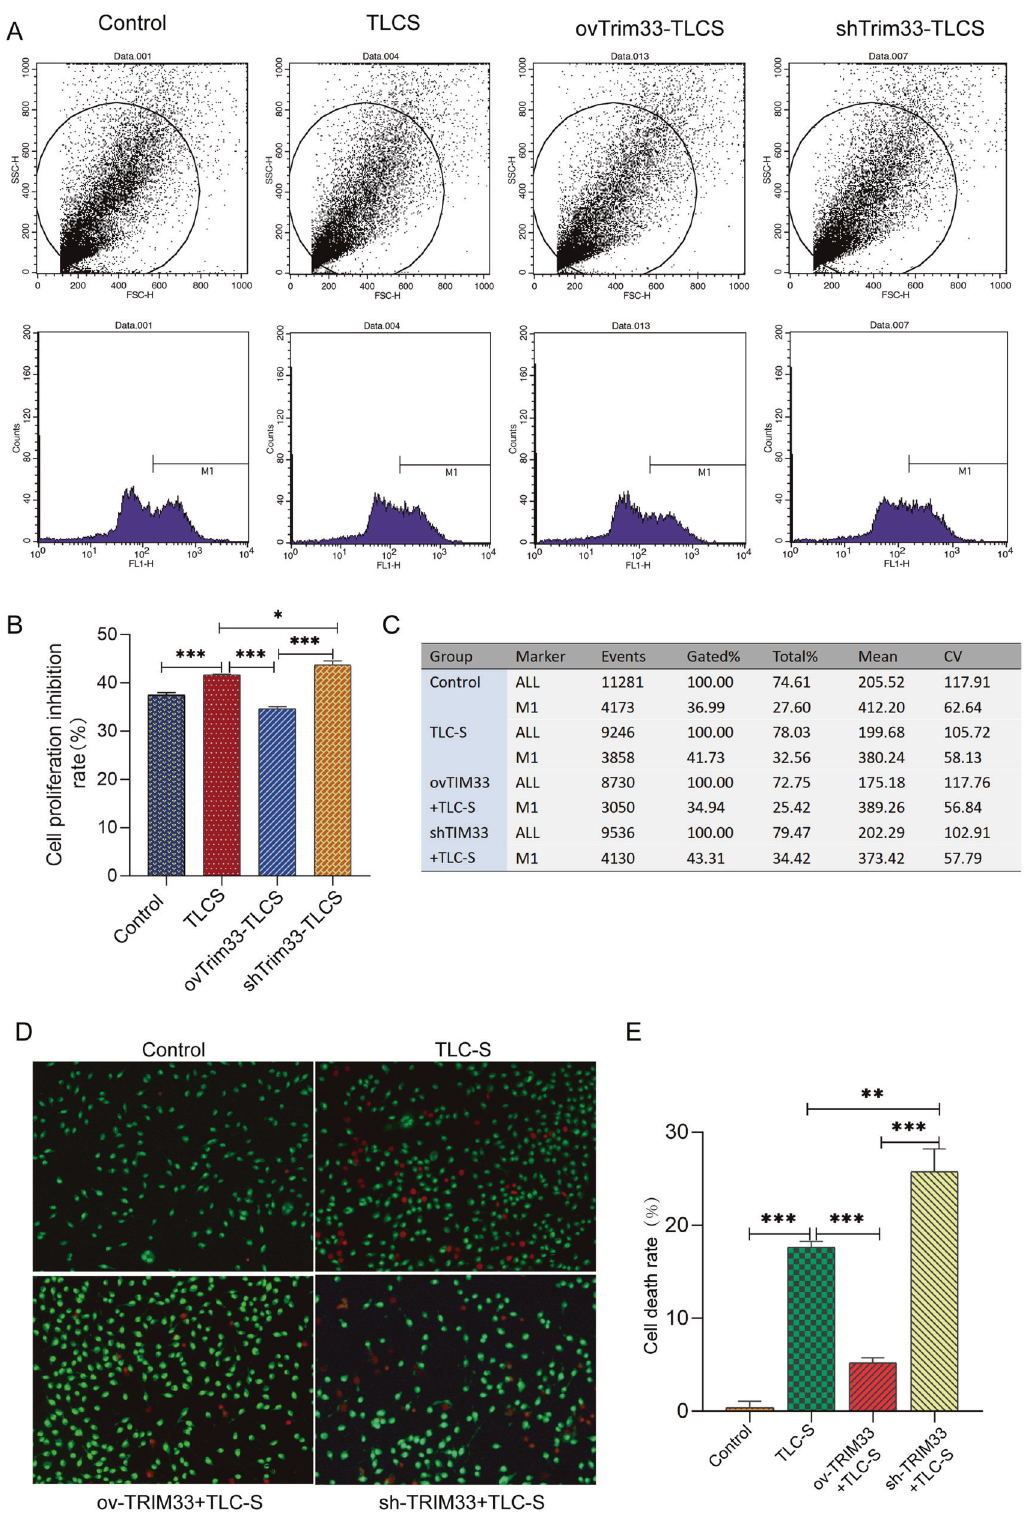
Fig. 2 Trim33 can maintain the viability of acute pancreatitis acinar cells and reduce their necrosis. A , B Cell viability detected by CFSE method, M1 is the cell proliferation inhibition rate. C The fi gure counts the number (Events) and the proportion (Gated%) of the active- de fi cient cells (M1) in each group. D , E AO/EB dual fl uorescence staining to observe cell necrosis in each group. For the alive cells, the nuclear chromatin are green and show a normal structure; for late apoptosis in cells, the nuclear chromatin are orange-red and pyknotic or fragmented ( t -test; *** p < 0.001, ** p < 0.01, * p < 0.05).